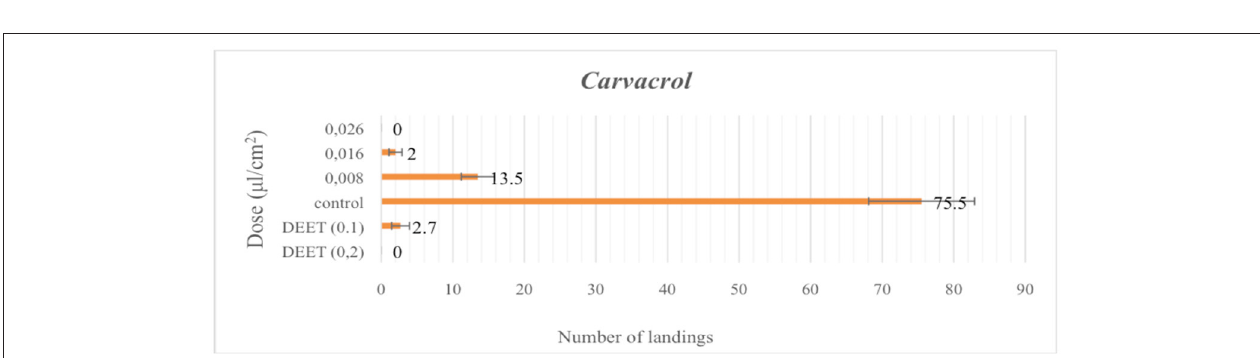
FIGURE 1 | Repellent activity of the oregano EO as mean number of landings ( ± SE) determined under laboratory conditions. Doses are expressed as µ L/cm. DEET was used as the positive control in two doses, 0.1 and 0.2 µ L/cm for 5min. (Means in a column followed by the same letter are not significantly different ( P ≥ 0.05), Mann–Whitney U -test).